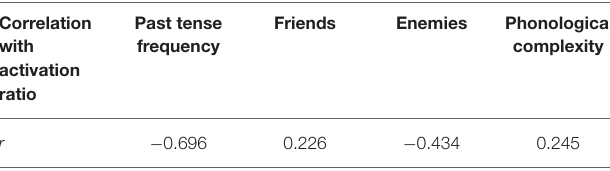
TABLE 1 | Correlations between the statistical properties of verbs and their activation ratio. Correlation